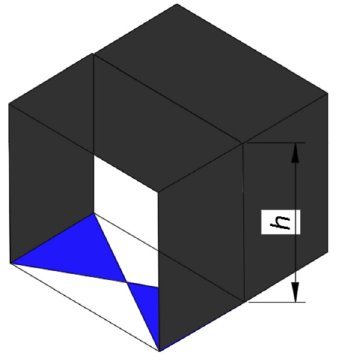
Figure 4. The antenna is placed in a metal box. The signal energy is enhanced by adjusting the height of the box. of the